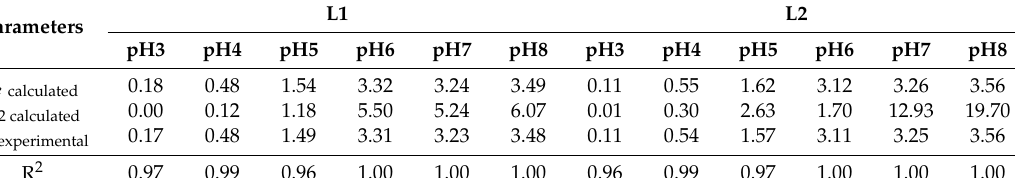
Table 4. Pseudo-second order data for di ff erent pH and two types of substrates.